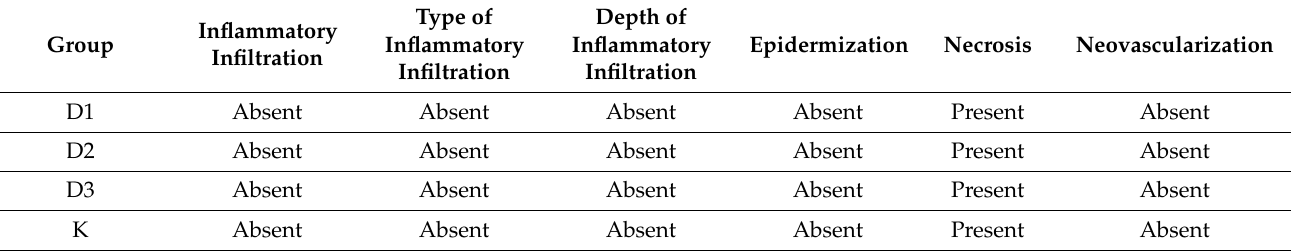
Table 7. Histopathological results from day 0.